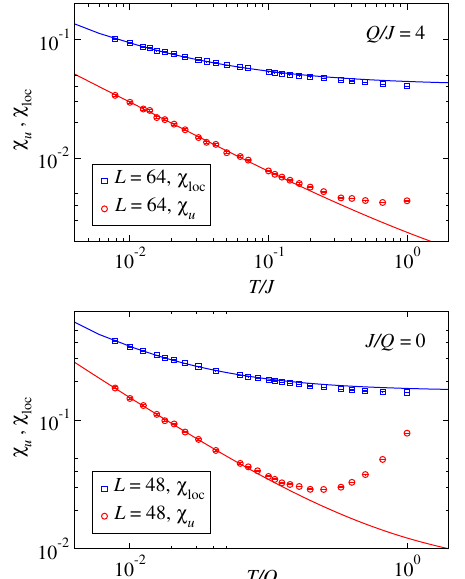
FIG. 22. Temperature dependence of the uniform and local susceptibilities of the random- Q model deep inside the RS phase, at Q=J ¼ 4 and J=Q ¼ 0 . The curves show fits of the low- T data to the predicted forms, Eq. (16) for χ , and the second line of u Eq. (18) for χ , enforcing common exponents for the two loc quantities. The fits give 1 – 2 =z ¼ 0 . 60 (cid:2) 0 . 10 ( Q=J ¼ 4 ) and 0 . 72 (cid:2) 0 . 06 ( J=Q ¼ 0 1 − 2 =z ¼ 0 . 60 (cid:2) 0 . 10 and 0 . 72 (cid:2) 0 . 06 for Q=J ¼ 4 , and J=Q ¼ 0 , respectively; i.e., the dynamic exponents are z ≈ 5 at Q=J ¼ 4 and z ≈ 7 when Q=J → ∞ .